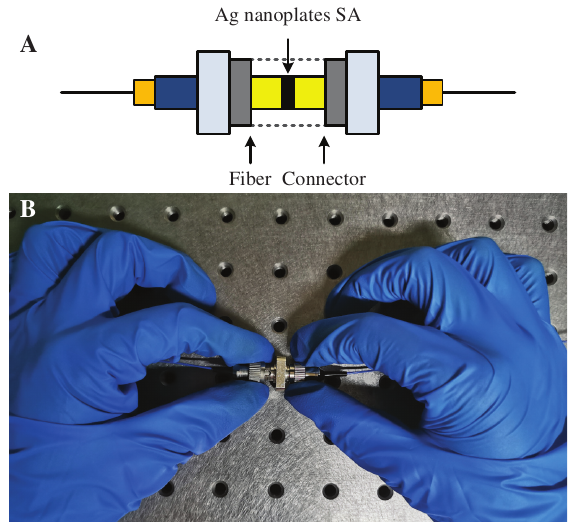
Figure 3: Self-assembly conducted Ag nanoplates SA.